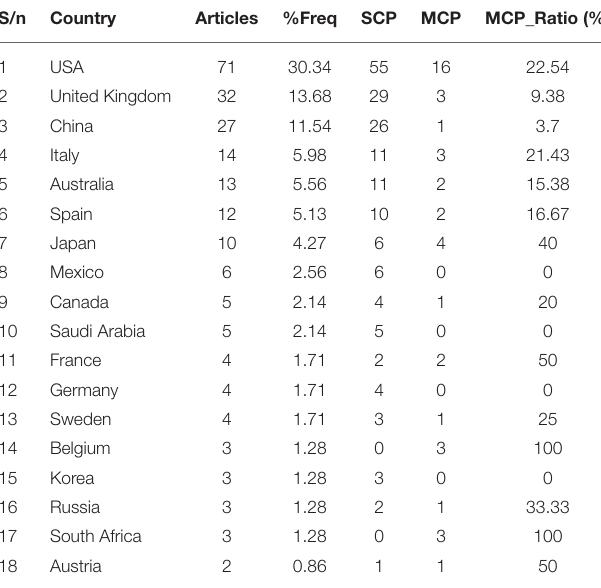
TABLE 4 | Corresponding author’s countries on MPP-AD related research from 1982 to 2019. S/n Country